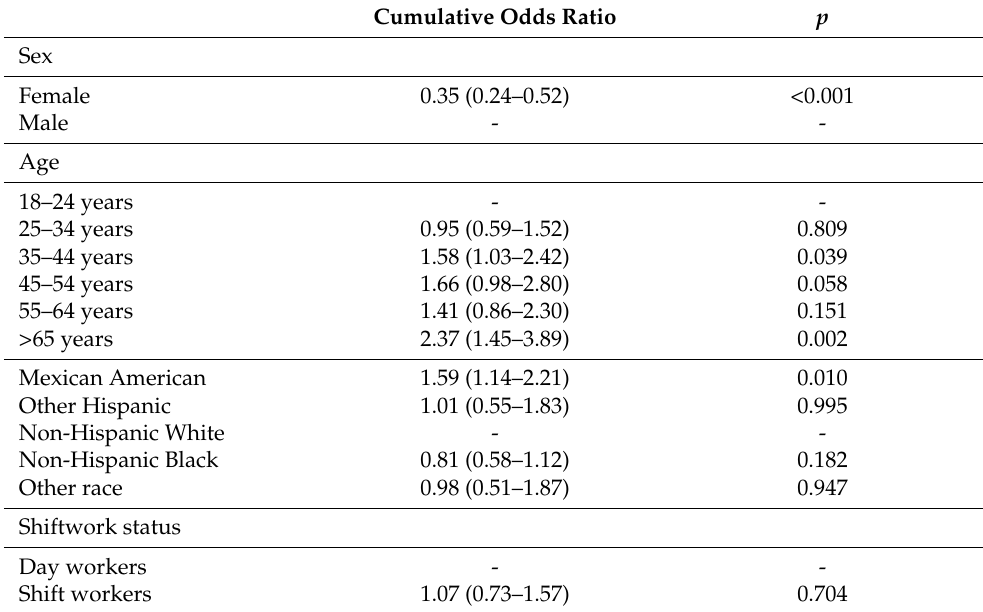
Table 6 legend: OR are displayed with their 95% confidence intervals and p -value. The symbol “-” indicates the reference category. p = p